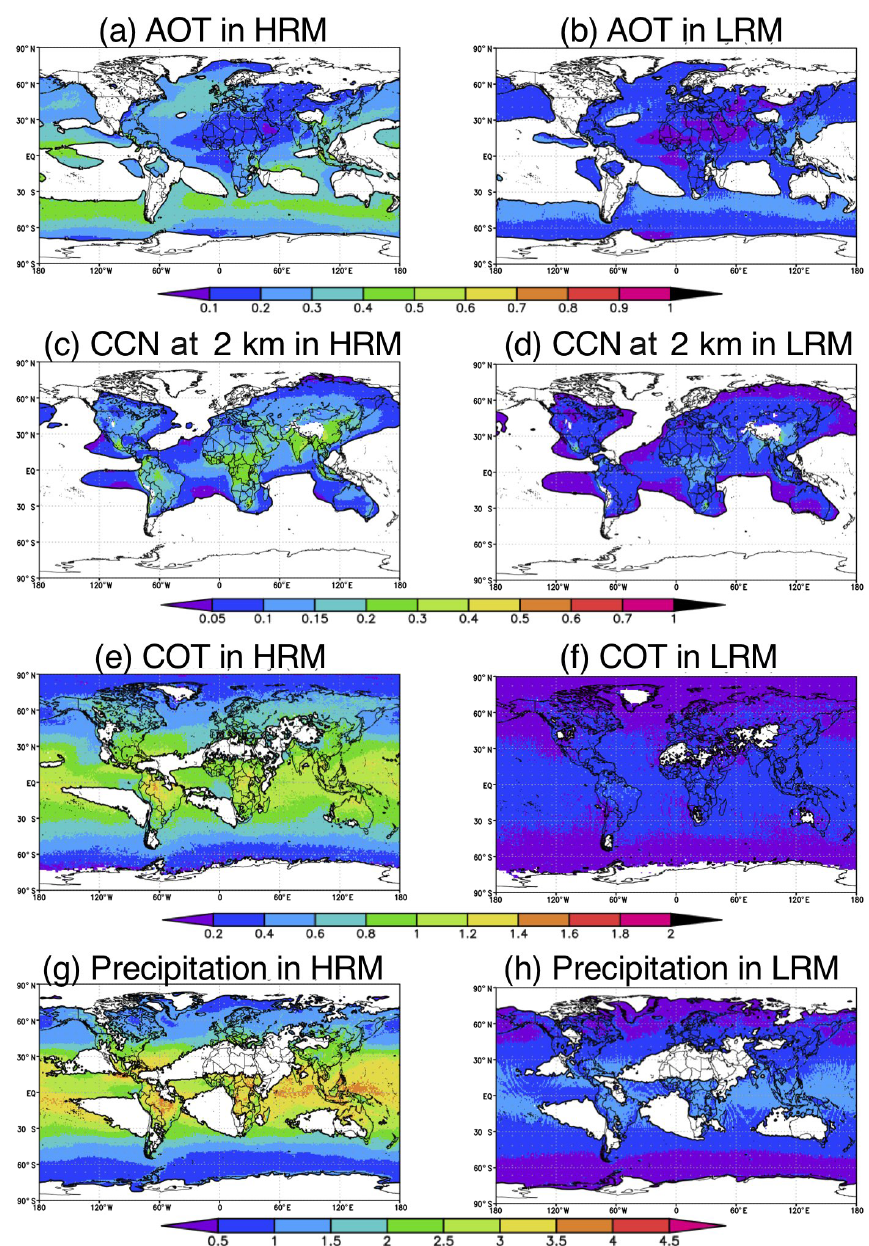
Figure 11. Global distributions of the ratio of the standard deviation to the average for the (a, b) AOT, (c, d) CCN at a height of approximately 2km, (e, f) COT and (g, h) precipitation on 1 ◦ × 1 ◦ grids using the 6-hourly output of both the HRM and LRM for a 1-year integration period. All units are in %. The transparency represents lower absolute values of each parameter: AOTs of < 0 . 1 in panels (a, b) , CCN of < 40cm − 3 in panels (c, d) , COTs of < 5 in panels (e, f) and precipitation fluxes of < 1mmd − 1 in panels (g, h)